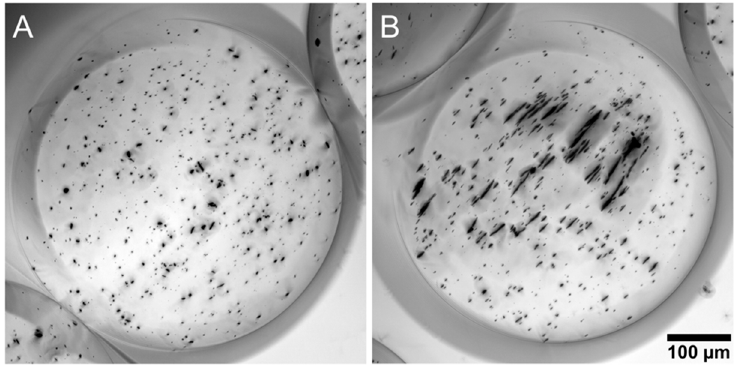
Figure 2. Minimum intensity projections taken from stacks of alginate capsules with ( A ) unaligned nanorods and ( B ) aligned nanorods.